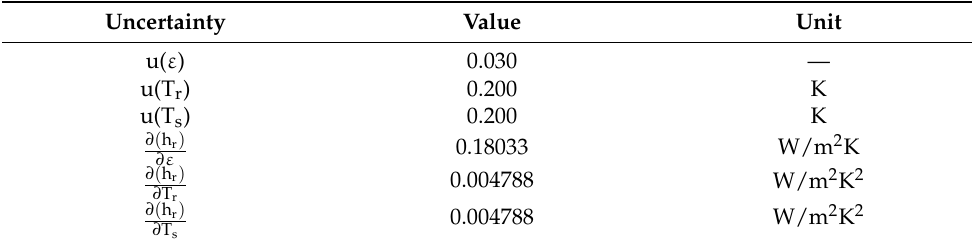
Table 2. Uncertainties in RHTC measurement.